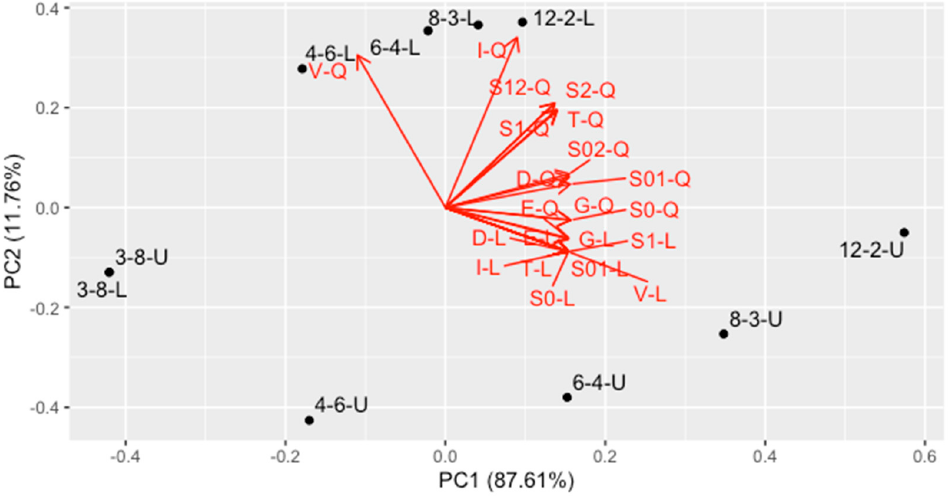
Figure 2. Principal Component Analysis of the various optimality criteria of compared designs. For the abbreviations, see text in Section 3.